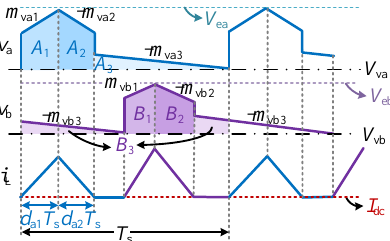
Figure 5. Geometric relationship between output voltage and control signal.